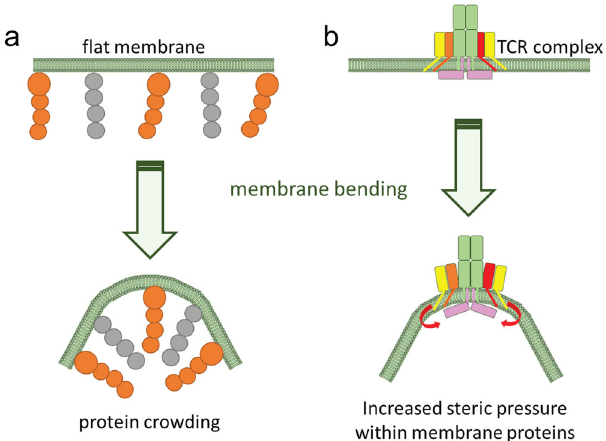
Fig. 5 Protein crowding. a Proteins associated with biological membranes occupy large surface areas on fl at membranes (left), but are crowded in the inner lea fl et when the membrane is bent inward (right). This creates steric pressure that opposes membrane bending. b Bending the plasma membrane directly around engaged TCRs may increase steric pressure on the CD3 complex and assist dissociation of buried CD3 ITAMs to the